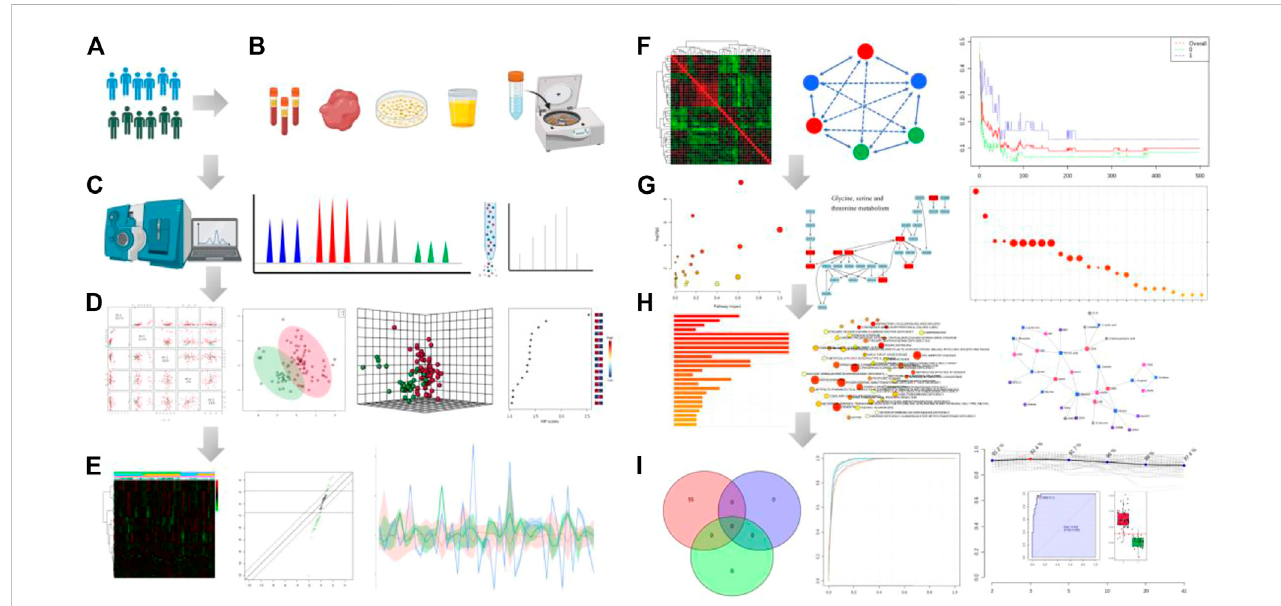
FIGURE 1 Analytical work fl ow of typical metabolomic analysis. It includes several basic steps: experimental design (A) , sample collection (B) , metabolite pro fl ing (C) , data analysis (D − F) , functional interpretation (G, H) and potential application of the integrated datasets (I) . Step (A) The experimental design based on phenotype analysis or diagnosis and treatment. Step (B) Sample preparation through deproteinization and/or centrifugation of bio fl uids. Step (C) Metabolite separationonacolumn(chromatography)anddetectionofanalytesignalthroughMSorNMRspectroscopy.Metabolitescanbeidenti fi edonthebasisof a combination of retention time and MS signature. Step (D) The data pre-processing and normalization of raw signals). Then, pattern recognition analysis and computational methods after data collection. Step (E) Expression analysis of the differential metabolites by which data is fi ltered for signi fi cant biomarkers of interest. Heatmap plot shows the differential metabolites in the statistical analysis function. Step (F) Clustering correlation patterns analysis among different datasets.Step (G) Pathwayenrichmentoverview.Circlesizeandcolorarebasedonthepathwaysizeand p -value.Step (H) Theenrichedmetabolismpathway and joint pathway analysis in the correlation network. Step (I) Analysis model of diagnosis, prognosis and treatment based on the candidate metabolite features using classical univariate and multivariate ROC curve analyses. All images were obtained using the example data provided by the MetaboAnalyst 5.0 and fi gures also created by